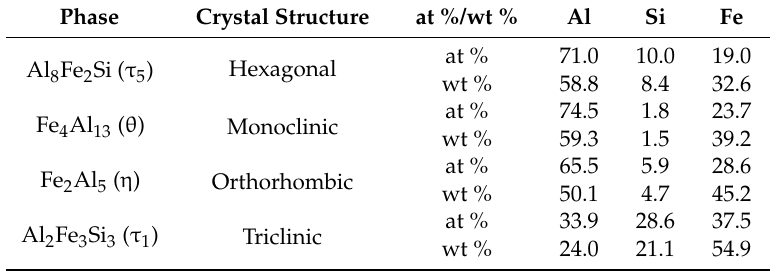
Table 4. Composition and crystal structure of the phases shown at 690 ◦ C in the phase diagram. Phase Crystal